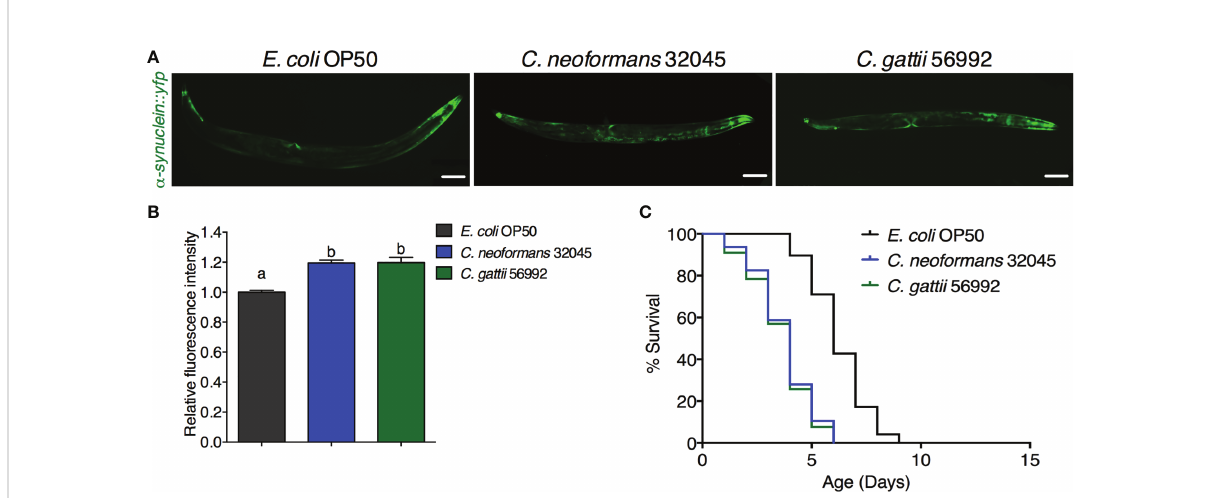
FIGURE 2 Infections of C neoformans and C gattii induced a -synuclein accumulation in C elegans . (A) C elegans strain NL5901 expressing YFP in muscle cells were exposed to either C neoformans (ATCC#32045) or C gattii (ATCC#56992) (scale bar = 200 m m). (B) Quantitation of YFP expression in muscle cells was measured by using ImageJ software. The data represented as mean ± SD (n = 30). a – b Indicated statistically signi fi cant differences between experimental conditions ( P < 0.05) by two-way ANOVA. (C) Percent survival of worms fed with C neoformans or C gattii. Worms that fed with E coli OP50 alone were served as mock-infected controls (n = 50). Survival was analyzed using Kaplan-Meier lifespan analysis. P -value was calculcated using log-rank test. Mean lifespan in each condition was summarized in Table